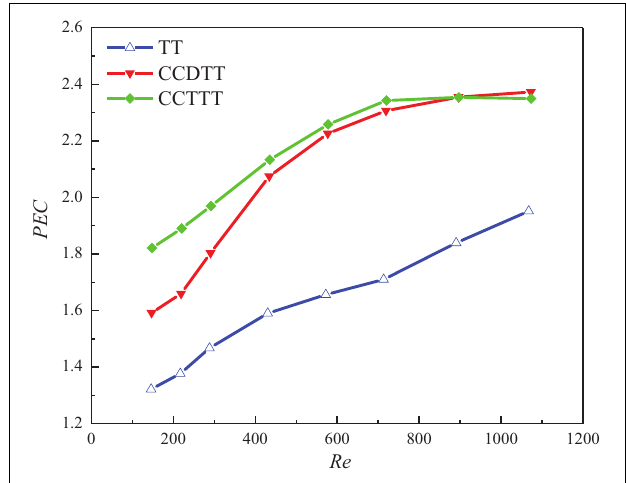
FIGURE 7 | Variation of PEC with the Reynolds number for FLiBe in the tube fitted with TT, CCDTT, and CCTTT ( y = 3).